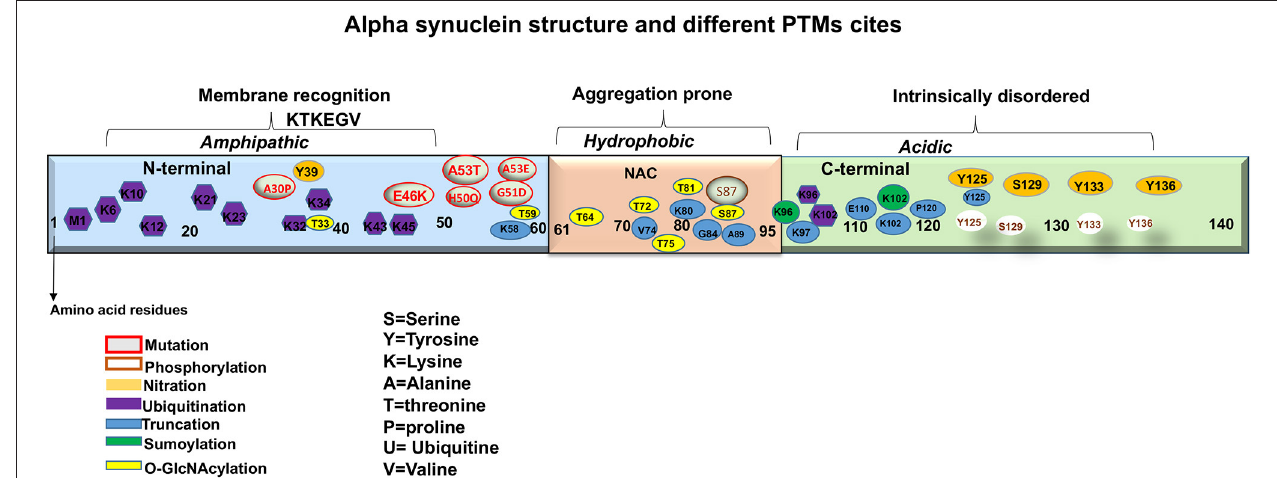
FIGURE 2 | A representation of aSyn structure and main sites of mutations and post-translational modifications (PTMs).